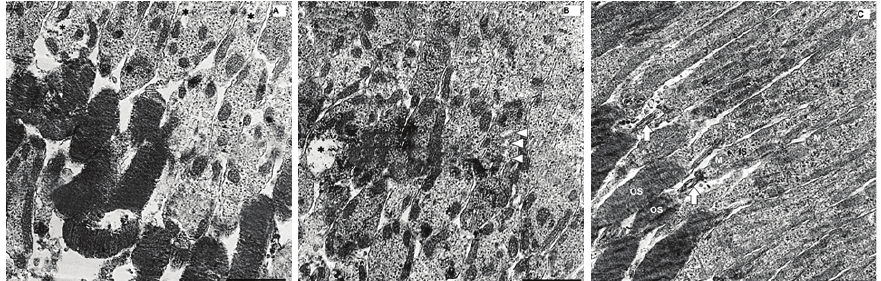
Figure 2. Electron micrographs showing the outer segments (OS) and inner segments (IS) in group D (A and B) and group DG (C). (A) & (B): Most of the inner segments are swollen and markedly vacuolated (asterisks), contain degenerated mitochondria (white arrowheads), and the outer segments are severely disorganized. (C) Orderly array in most of the photoreceptor segments with mild injuries. White arrows: Two connecting cilia; M, mitochondria (Scale bar, 2 µm).